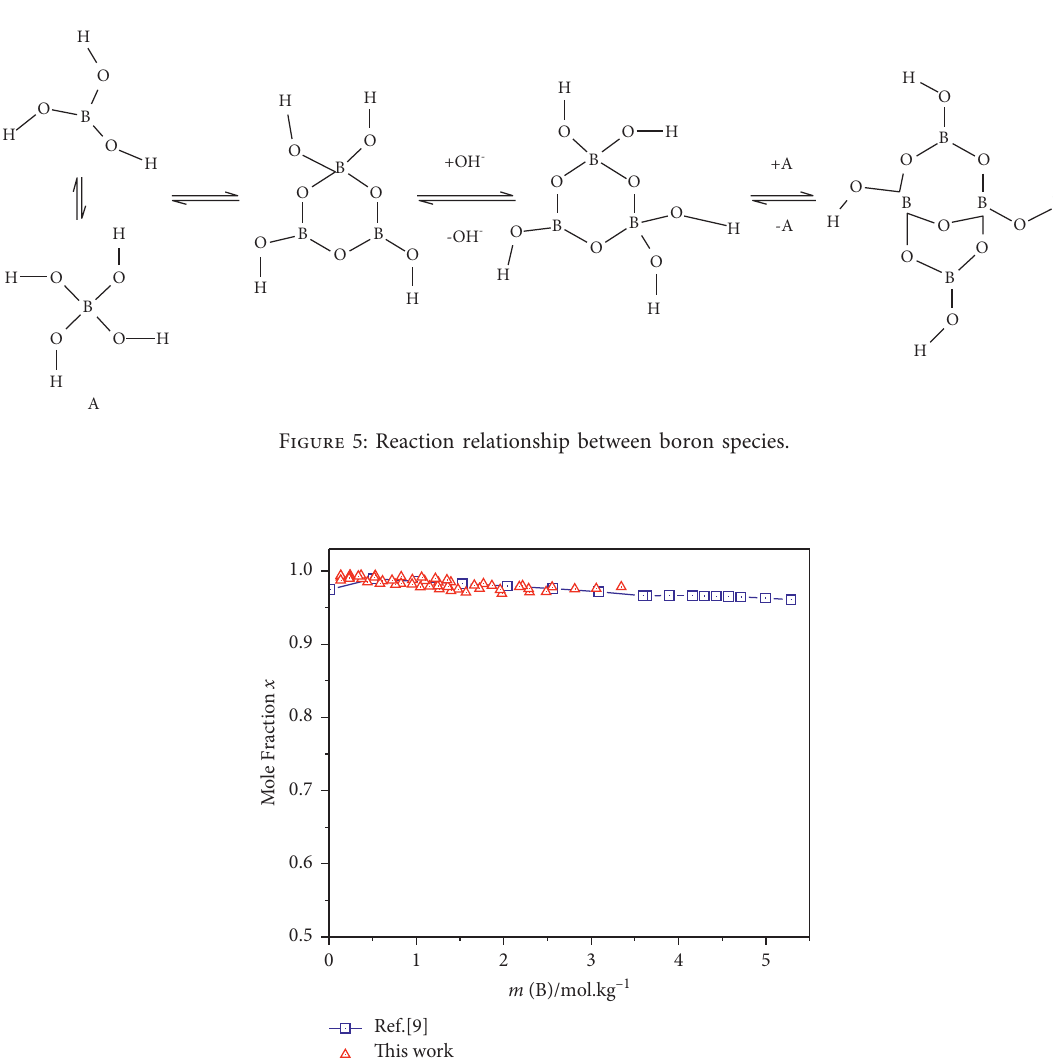
Figure 6: Comparison of the mole fraction of B(OH) Pitzer model